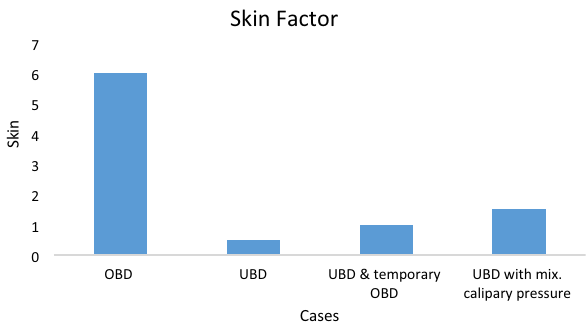
Fig. 2 Comparison of skin in oil reservoir for OBD and UBD (Ding et al.